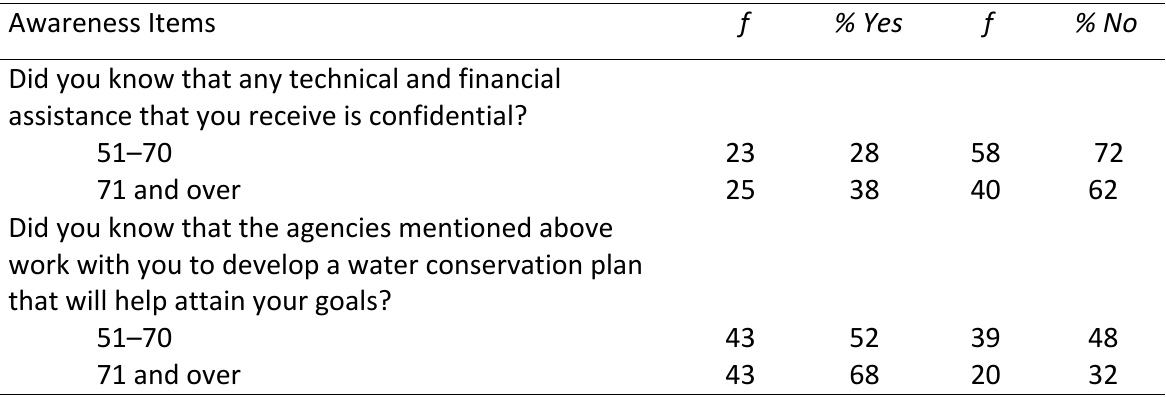
Descriptive Statistics of Age on Awareness of Natural Resources Conservation Service & Texas State Soil and Water Conservation Board